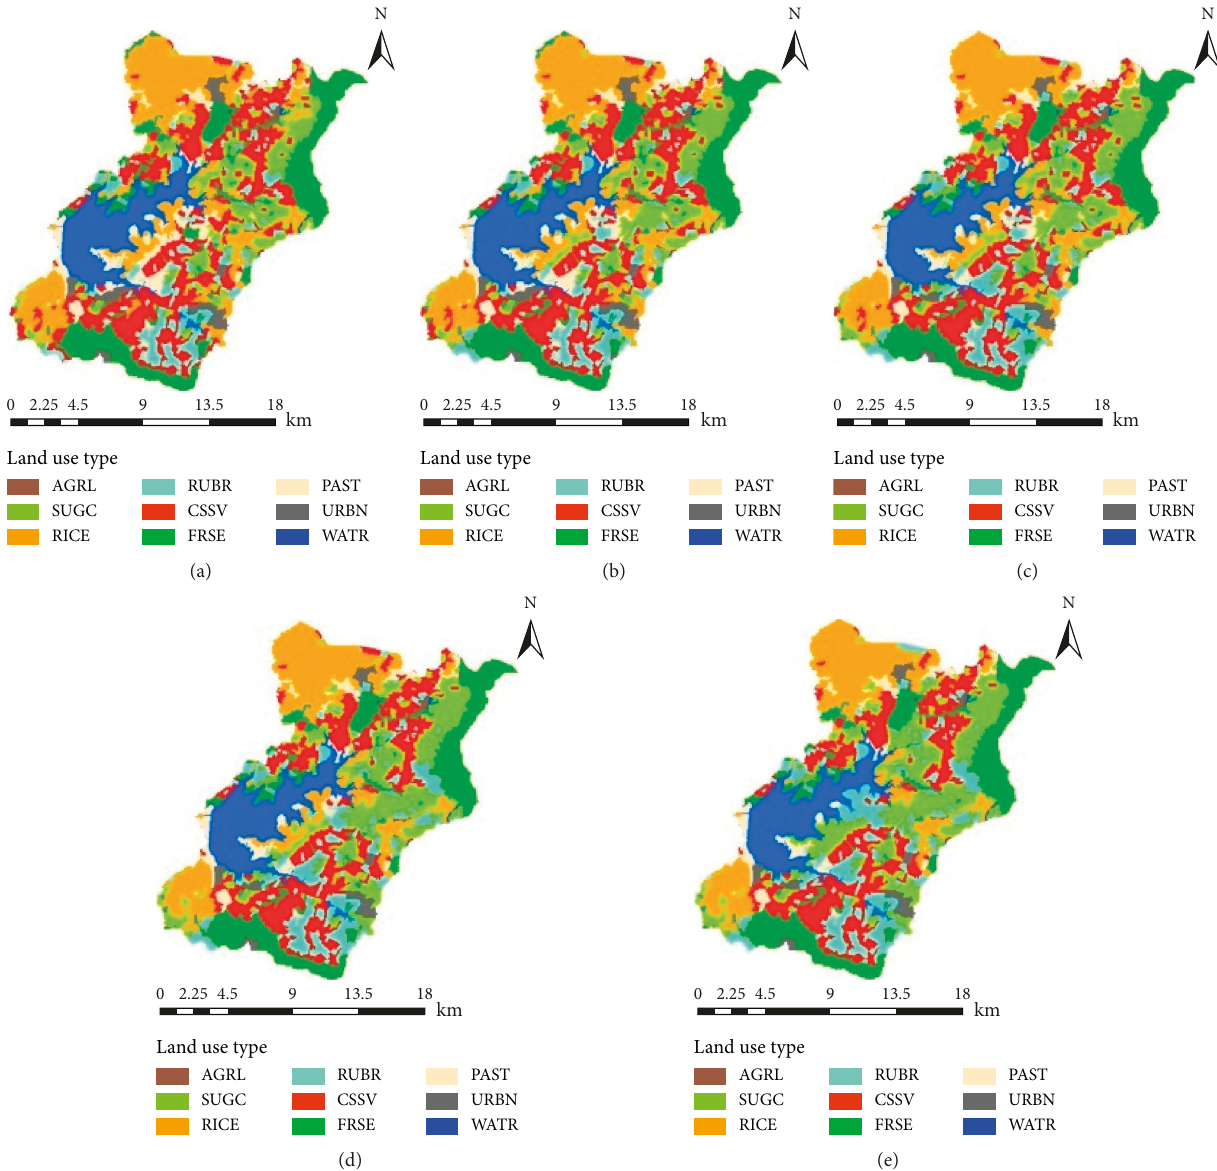
Figure 9: Simulated land use maps for 2018–2067 above the Huay Sabag area. (a) Year 2024. (b) Year 2038. (c) Year 2052. (d) Year 2066. (e) Year